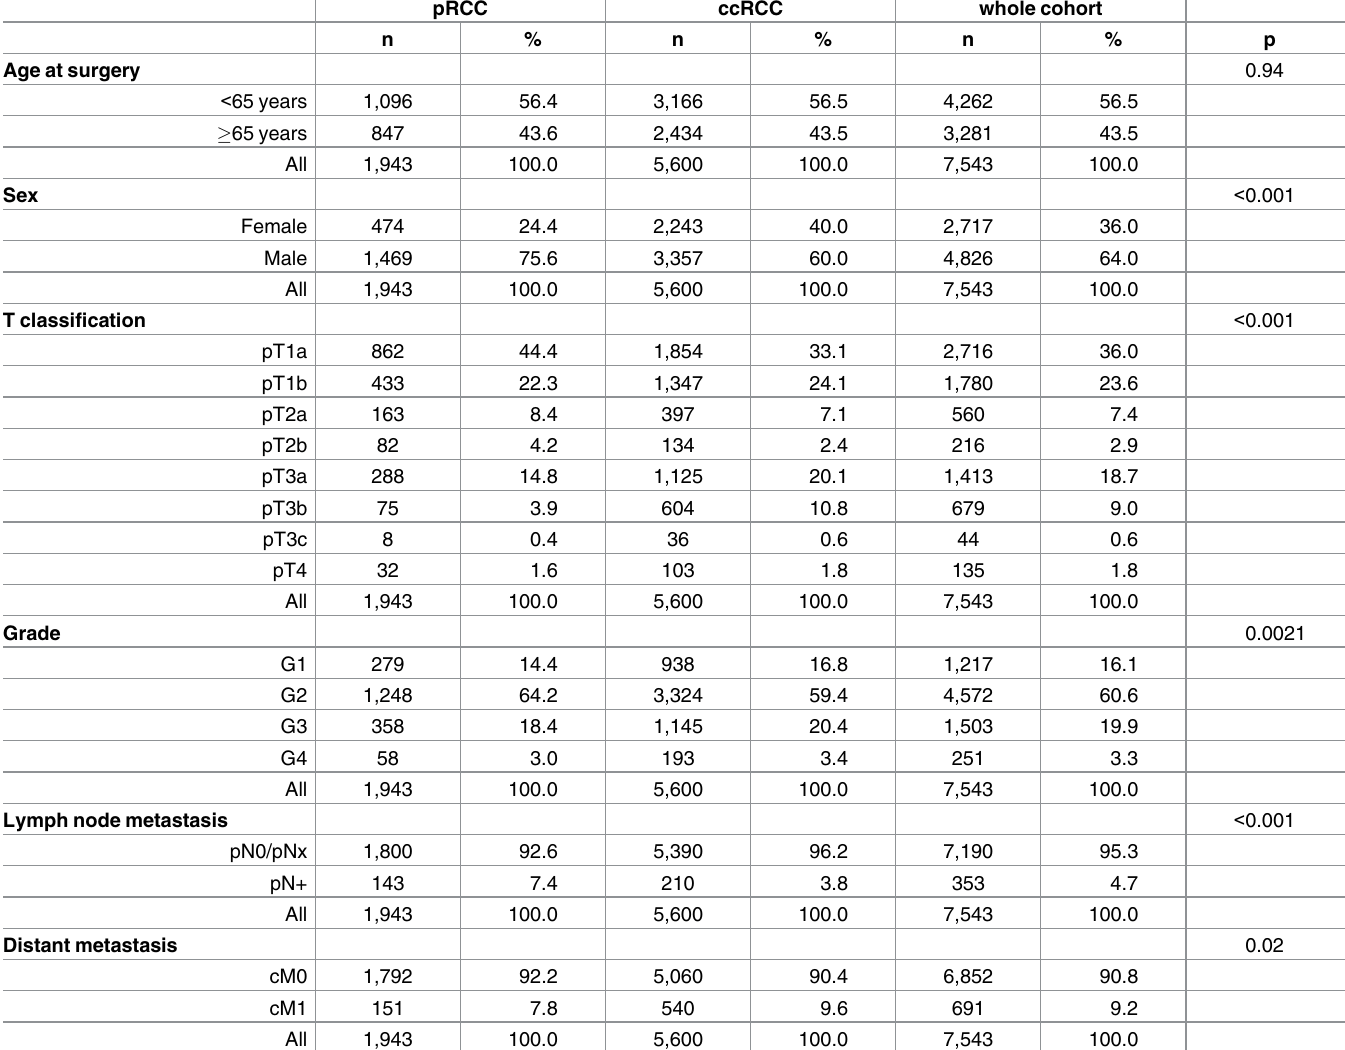
Table 1. Summaryof clinical and pathological features and group differences between papillary renal cell carcinoma (pRCC) and clear cell renal cell carcinoma (ccRCC) (whole cohort, n =